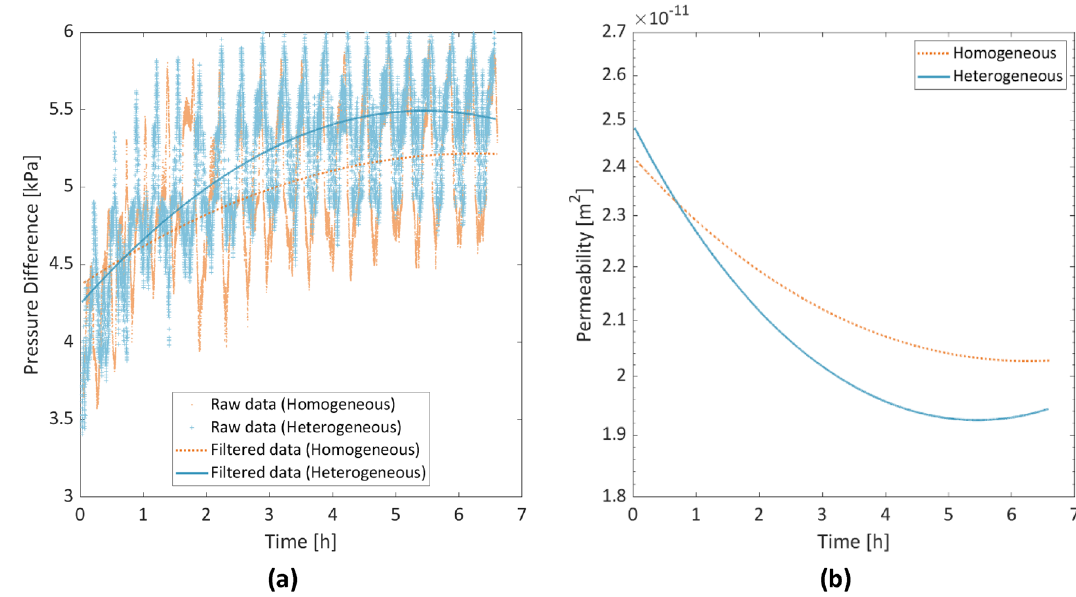
Figure 12. ( a ) Raw and filtered data (with the Savitzky-Golay filter 45 ) of pressure difference evolution. ( b ) Calculated intrinsic permeability evolution during CS